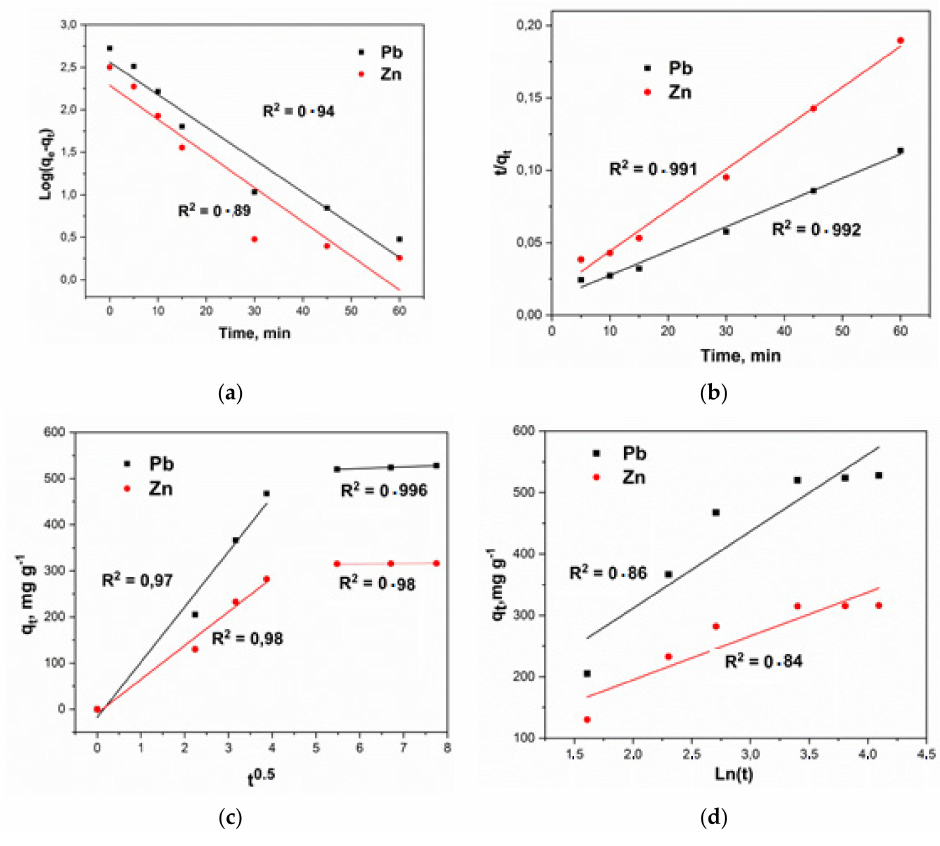
Figure 10. Kinetic modeling: ( a ) Pseudo-first order, ( b ) Pseudo-second order, ( c ) Intraparticle diffusion model, ( d ) Elovich model.